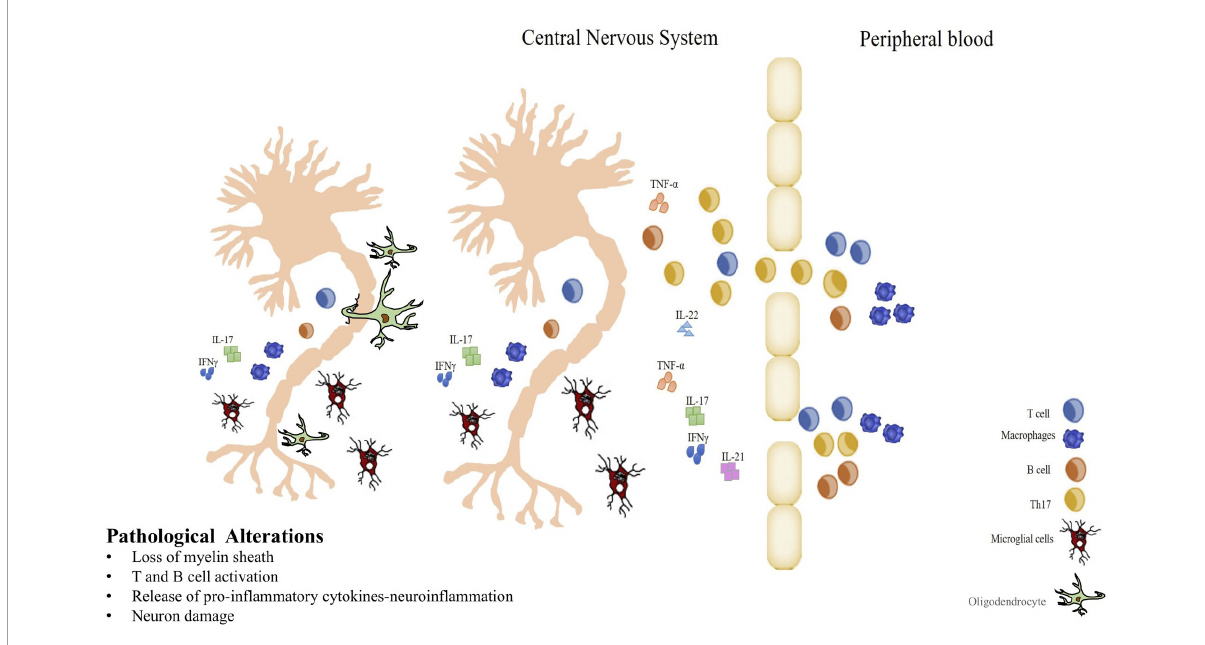
FIGURE2 Immunopathogenesis of MS. Blood Brain Barrier breakdown, autoreactive cell infiltration and inflammatory cytokines production in CNS. Myelin-specific T cells entering in the central nervous system (CNS) initiate an inflammatory response, and B cells participate in myelin breakdown secreting antibodies. Resident CNS microglial cells have the capacity to secrete proinflammatory molecules that can damage the myelin sheath and/or oligodendrocytes. When oligodendrocytes are damaged and myelin that typically isolates the axons of nerve cells is